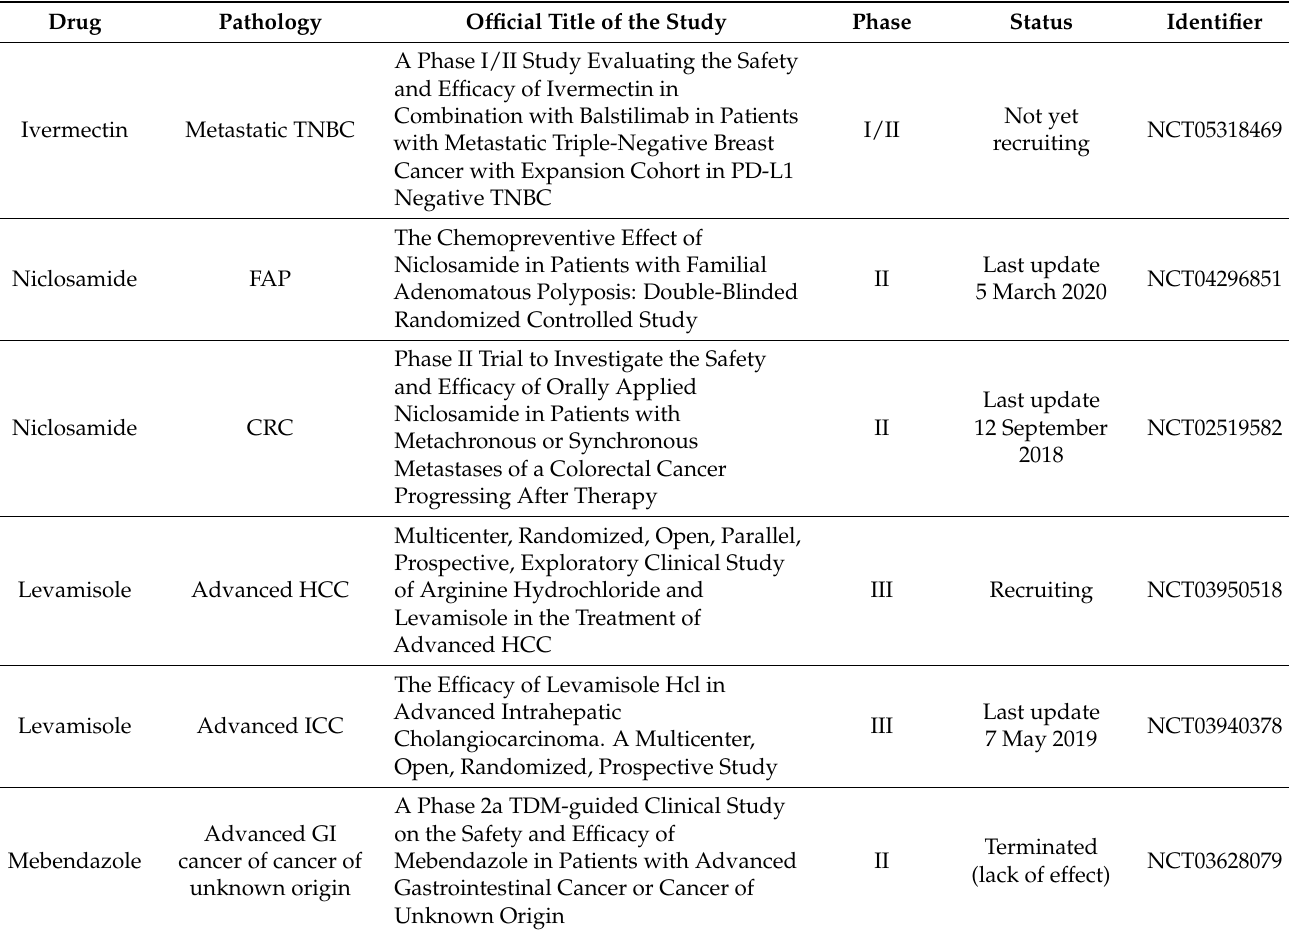
Table 2. Current clinical trials employing anthelmintic drugs to treat